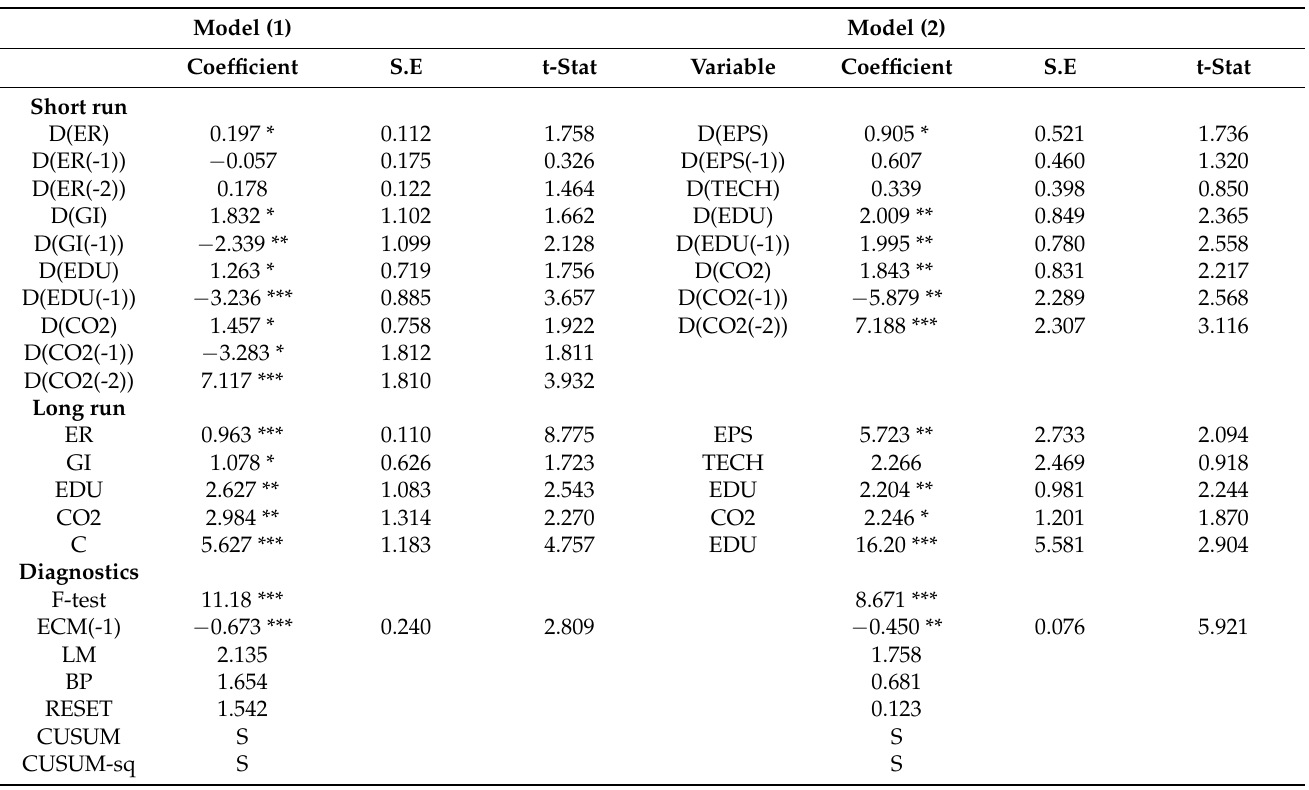
Table 3. Short and long run estimates of